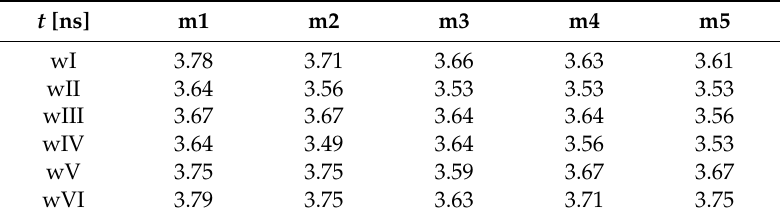
Table 4. Two-way travel time through the slabs.